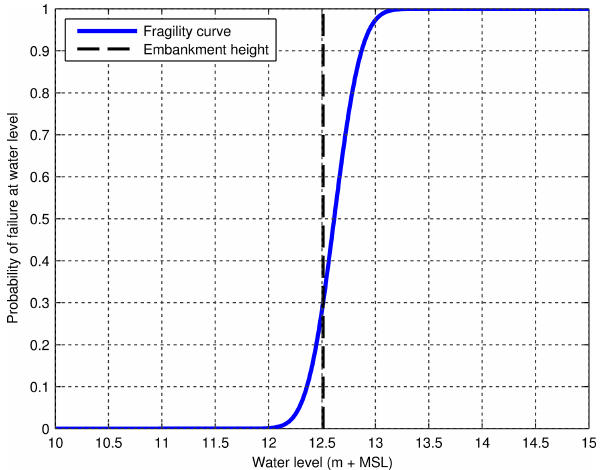
Figure 3. Fragility curve for dike-ring